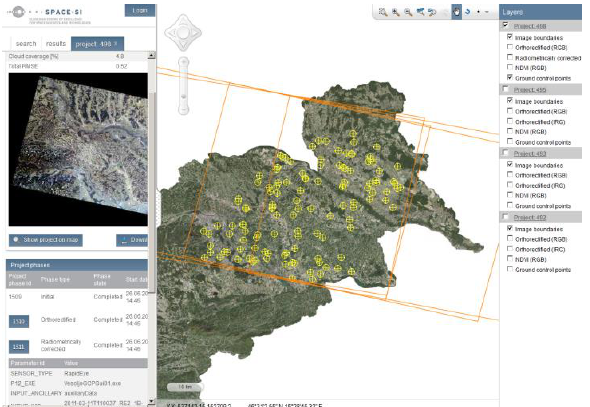
Figure 13. End-user viewer with attribute part (left) and map part (centre and right). For each processed image used GCPs can also be